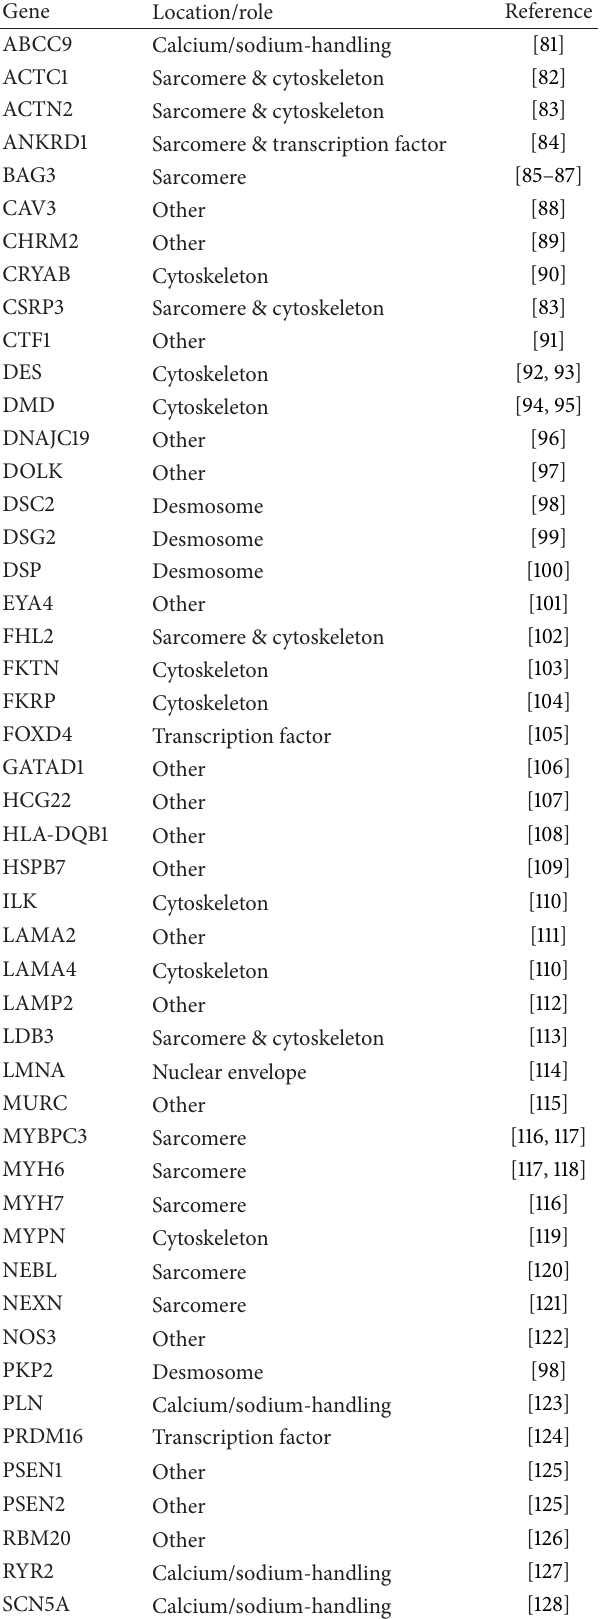
Table 1: Genes with mutations associated with DCM in humans. Gene